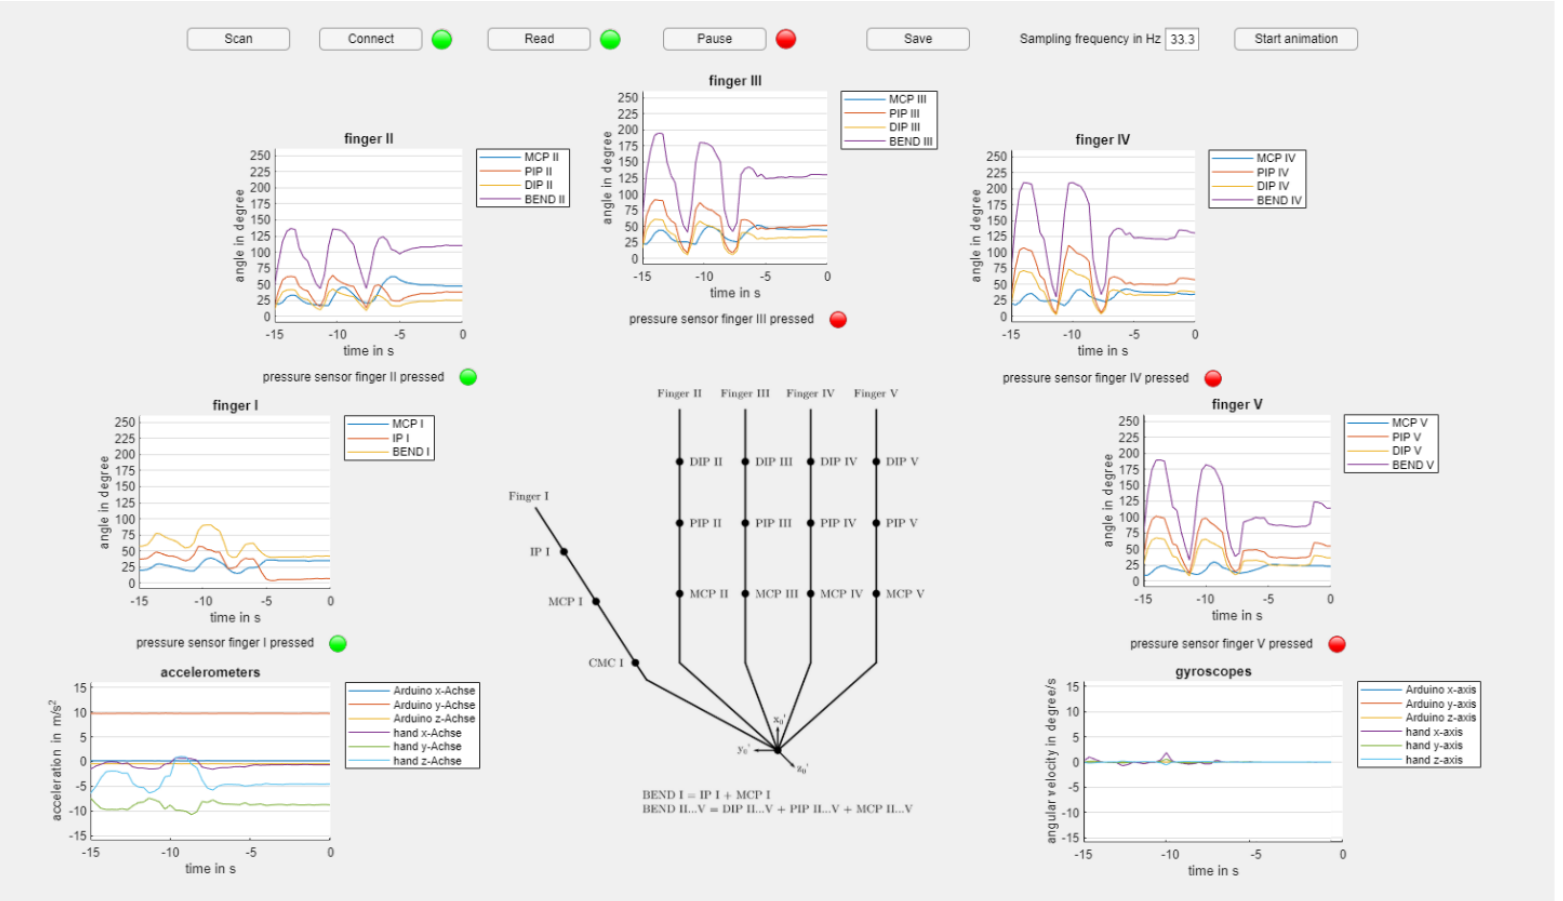
Figure 11. GUI of the MATLAB ® script for SenGlove. Menu at the top to scan for devices (Scan), connect to a device (Connect), start reading data (Read), pause reading data (Pause), store read data (Save), display of the current sampling frequency (Sampling frequency) and to start the 3D animation of the hand (Start animation). In center: Simplified kinematic model of a human hand with a degree of freedom of 15. Fingers numbered I (thumb) to V (pinkie finger). Joints: Carpometacarpal (CMC), Distal Interphalangeal (DIP), Interphalangeal (IP), Metacarpophalangeal (MCP), Proximal Interphalangeal (PIP). Global coordinate system with the axes x (cid:48) , y (cid:48) and z (cid:48) . Subplots (from left to right) for the linear acceleration of the hand (accelerometers), angle in degree for Finger I to V with pressure information for 0 0 0 each finger underneath (green = threshold exceeded, red = threshold not exceeded), angular velocity of the hand